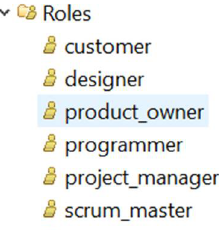
Figure 8. Examples of tasks in VSE Composer. A work product is an item associated with a task, which acts as the input or the out- put of the task. As shown in Figure 9, there were 15 work products selected from ISO/IEC29110 and the Scrum methodology. The attribute of the work product is “state”, the status of the work product. Examples of these states are draft, reviewed, baseline, and release.